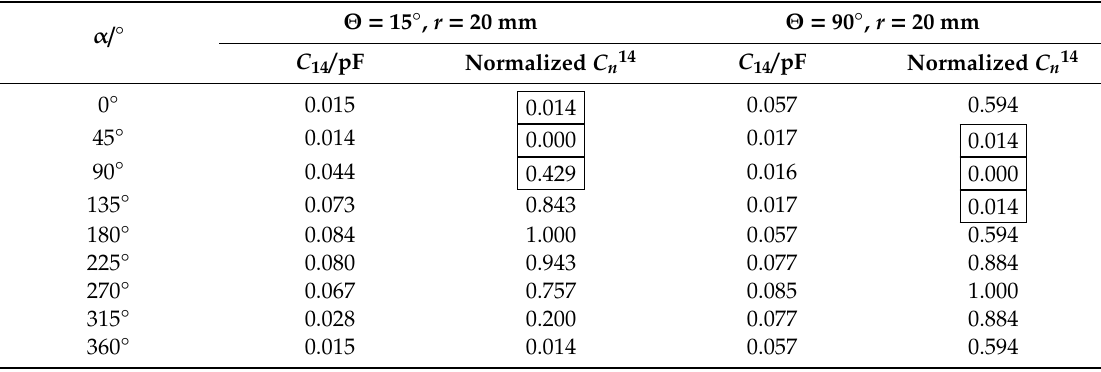
Table 1. The simulated capacitance (pF) and normalized values between E1 and E4.